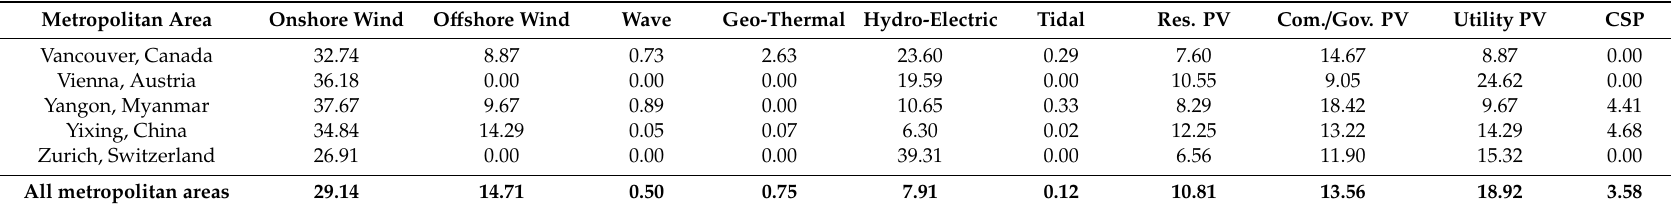
Table 4. Existing plus new nameplate capacities (MW) needed for each WWS electricity generation source in each metropolitan area to meet 2050 metropolitan area all-purpose end-use WWS load in the annual average. These capacities are determined by taking the product of end-use WWS load (Table 1) and the fraction of load met by each generator (Table 3), all divided by the product of the capacity factor and transmission / distribution e ffi ciency (Table 5). Metropolitan